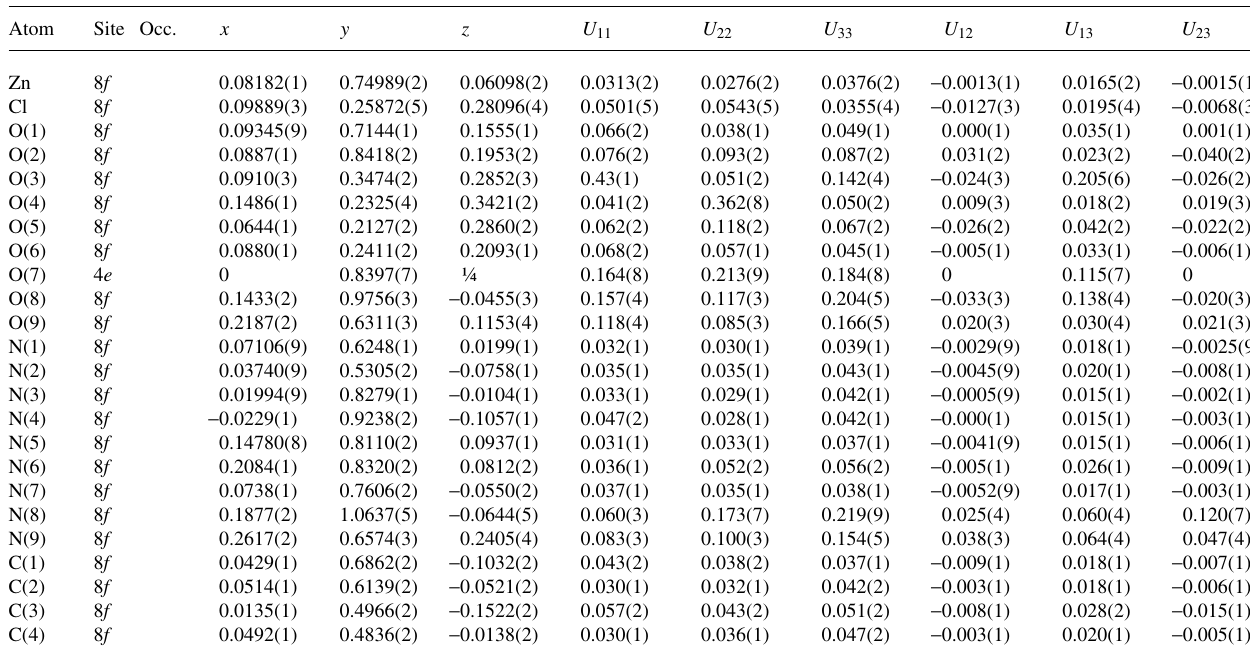
Table 3. Atomic coordinates and displacement parameters (in Å 2 ) .